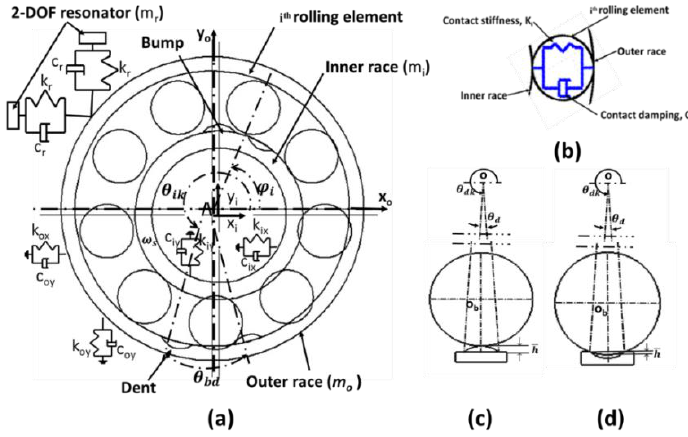
Figure 1. ( a ) Schematic of loaded ball bearing with simulated ball deformation; ( b ) simplified model of contact and damping force between ball and raceways; ( c , d ) schematic of contact relation between ball and bump, and ball and dent.